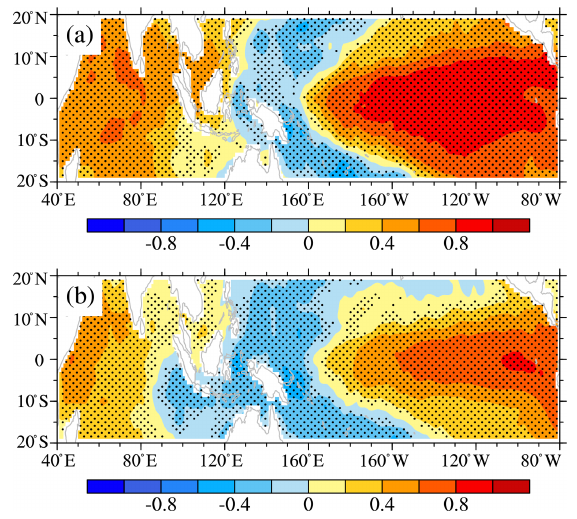
Figure 6. Regressions of the monthly SSTA onto the normalized (a) PC1 and (b) PIOAMI for the period from 1951 to 2005 (unit: ◦ C). The stippled areas for the SSTA denote the 99% confidence